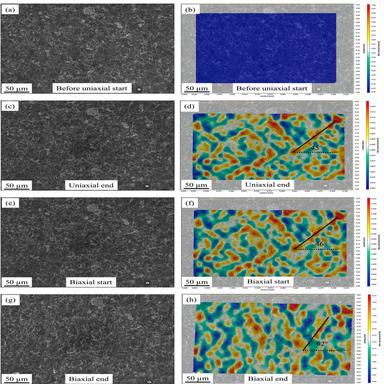
Micrographs of the centre of the DP600 specimen at (a) before uniaxial start, (c) uniaxial end, (e) biaxial start and (g) biaxial end during the strain path transition. Corresponding x-axis micro-strain (ex) distribution calculated from micro DIC analysis at (b) before uniaxial start, (d) uniaxial end, (f) biaxial start and (h) biaxial end during the strain path transition.